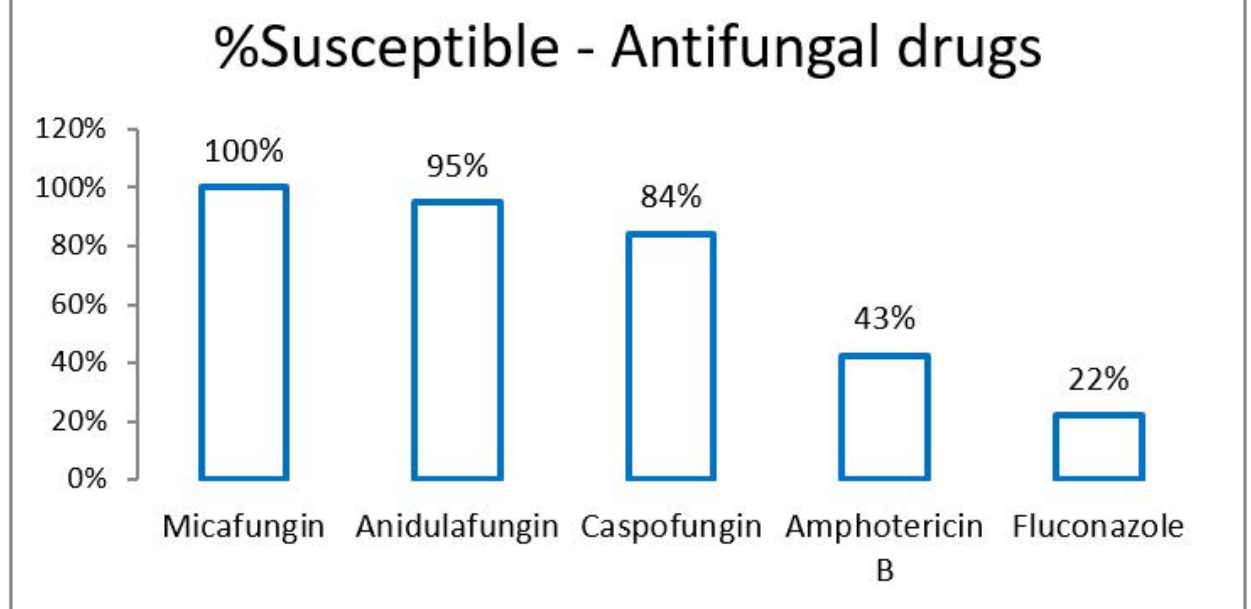
Figure 1. Susceptibility (%) of antifungal drugs in Candida auris .